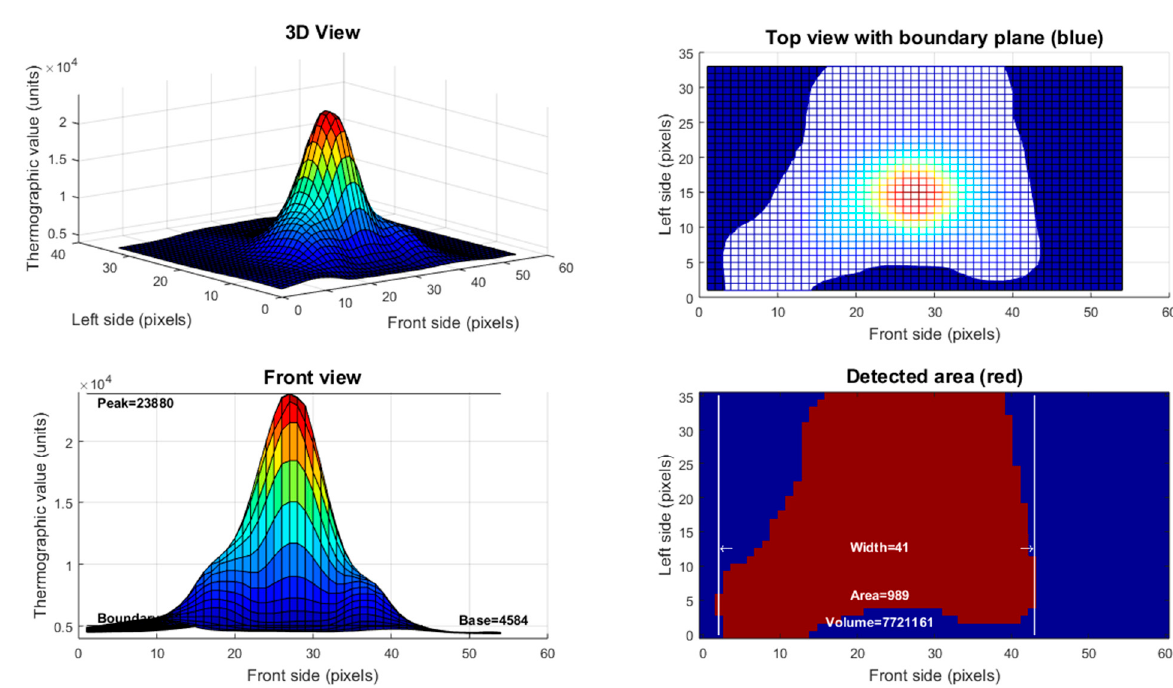
Figure 4. Thermal fields observed on the surface of sample 2 in thermographic value x pixels on image in three-dimensional view, top view, front view, and detected area.